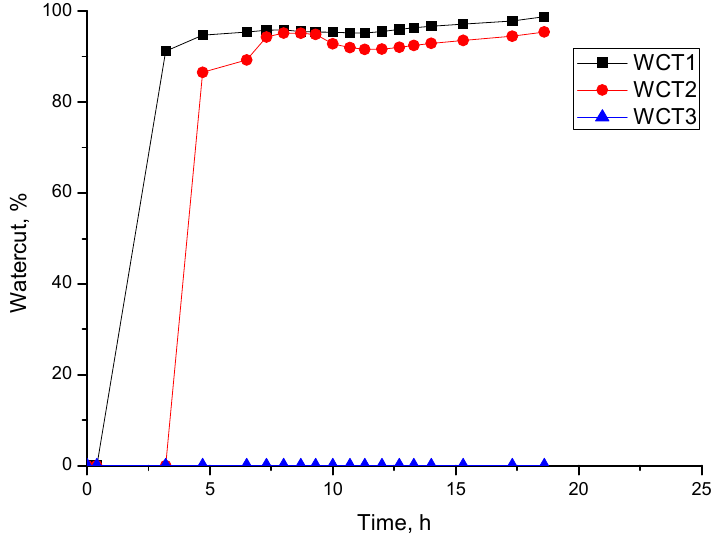
Figure 5. Watercut curves in each coreholder with time.